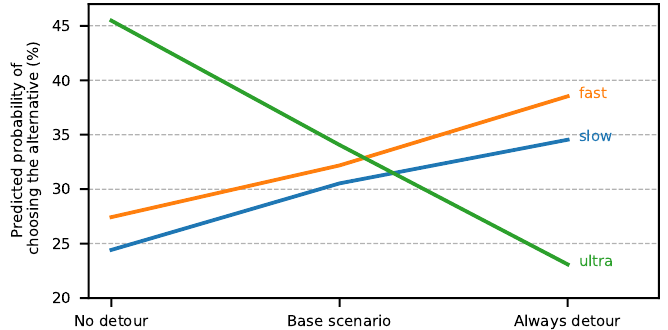
Figure 7. Predicted probabilities for a scenario with and without having to make a 5 min detour for an ultrafast charging